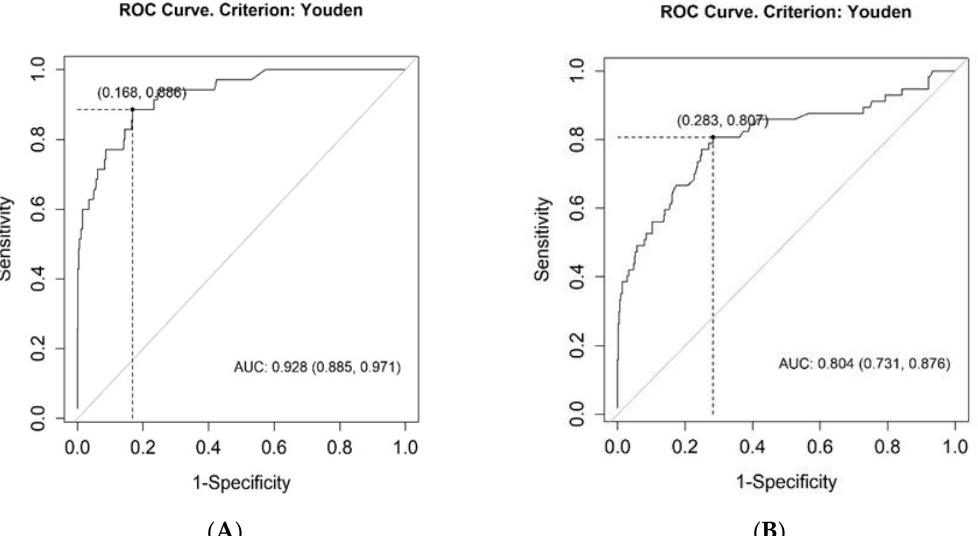
Figure 3. ROC Curves for the TRPG/AcT for the diagnosis of CTEPH ( A ) and for the diagnosis of pooled CTEPH and CTED groups ( B ). AUC — area under the roc curve; CTEPH — chronic thromboembolic pulmonary hypertension; CTED — chronic thromboembolic disease; ROC — receiver operating characteristic; TRPG/AcT tricuspid regurgitation peak gradient/pulmonary ejection acceleration time.